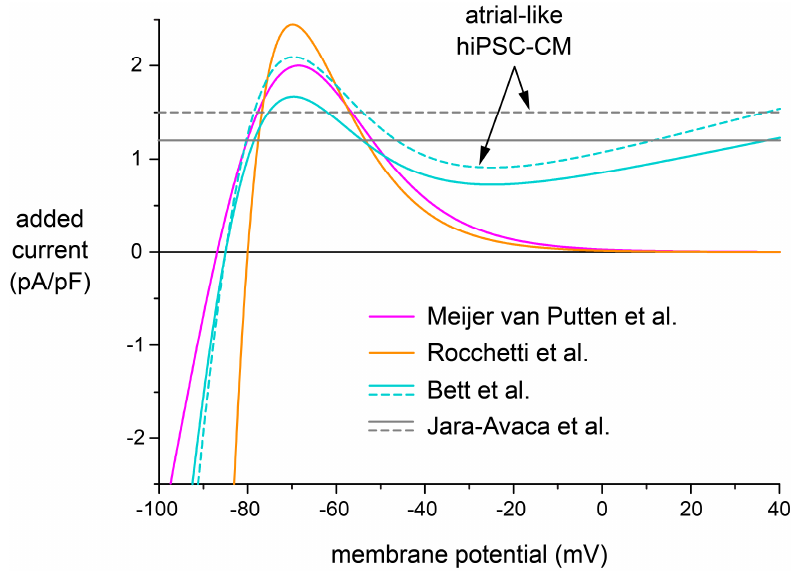
Figure 8. Current added to the ventricular-like and atrial-like hiPSC-CM model cells of Paci et al. [30,31] in order to obtain a resting membrane potential near − 80 mV. I K1 current–voltage relationships of Meijer van Putten et al. [5], Bett et al. [14], and Rocchetti et al. [15] as well as the hyperpolarising current of Jara-Avaca et al. [16].